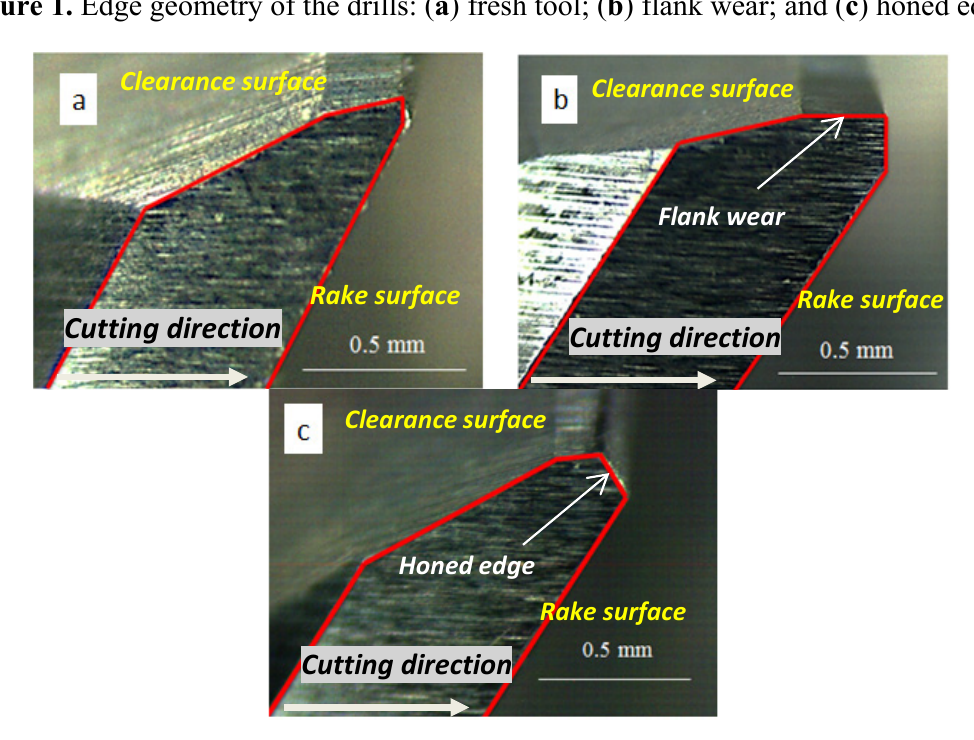
Figure 1. Edge geometry of the drills: ( a ) fresh tool; ( b ) flank wear; and ( c ) honed